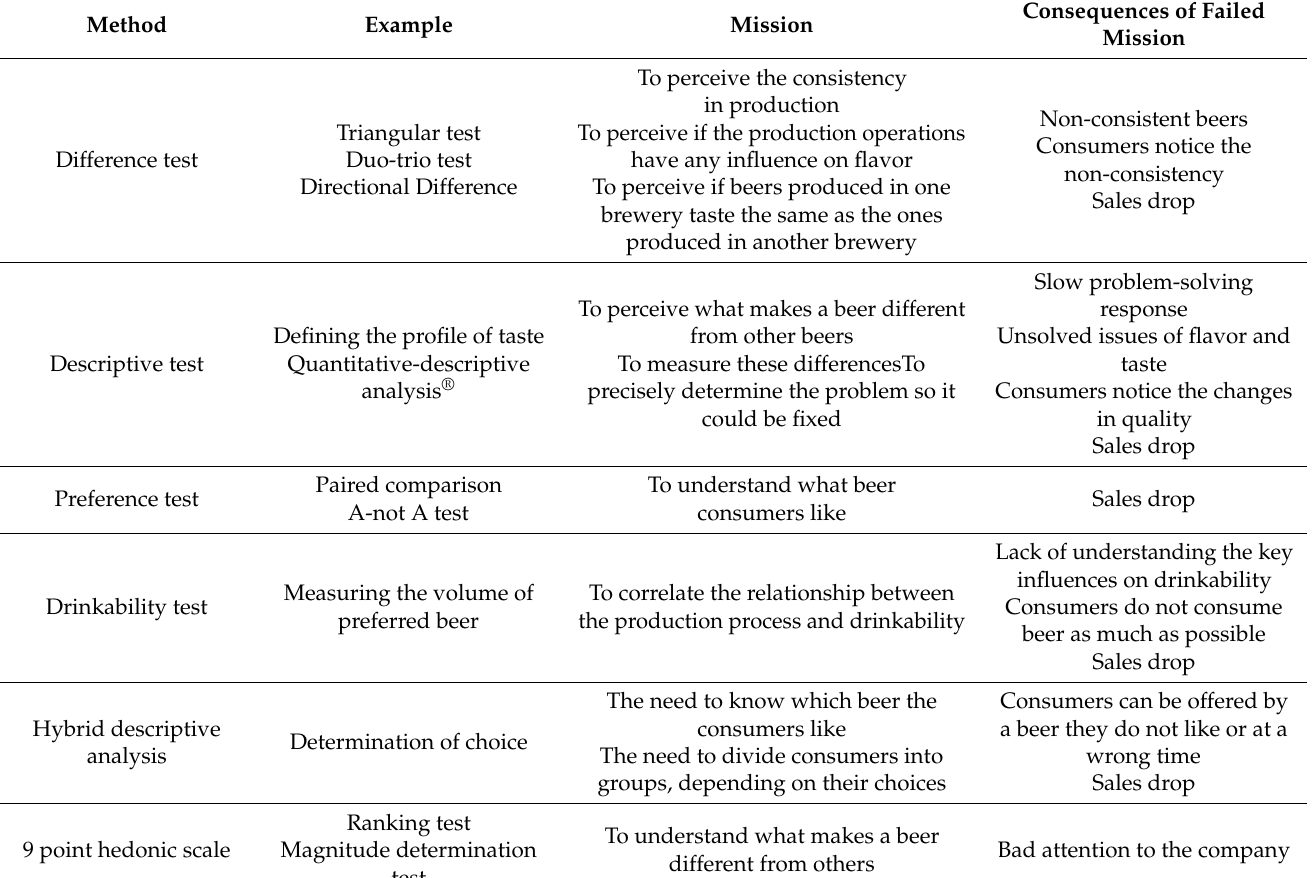
Table 3. Efficiencies of sensory analysis, adapted from